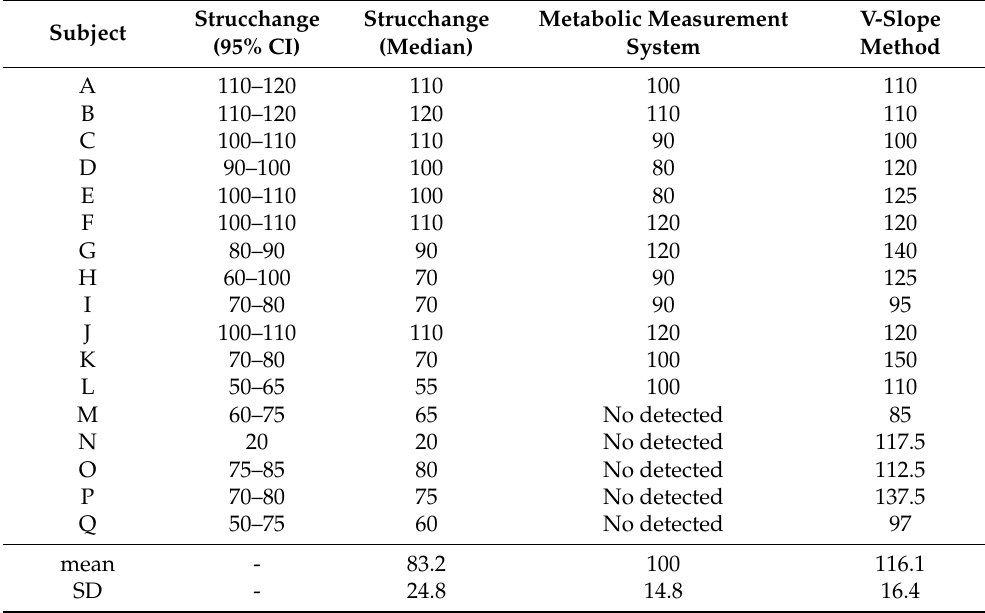
Table 4. AT by strucchange, V-slope methods, and respiratory metabolic analysis in RQ (numbers in table converted to